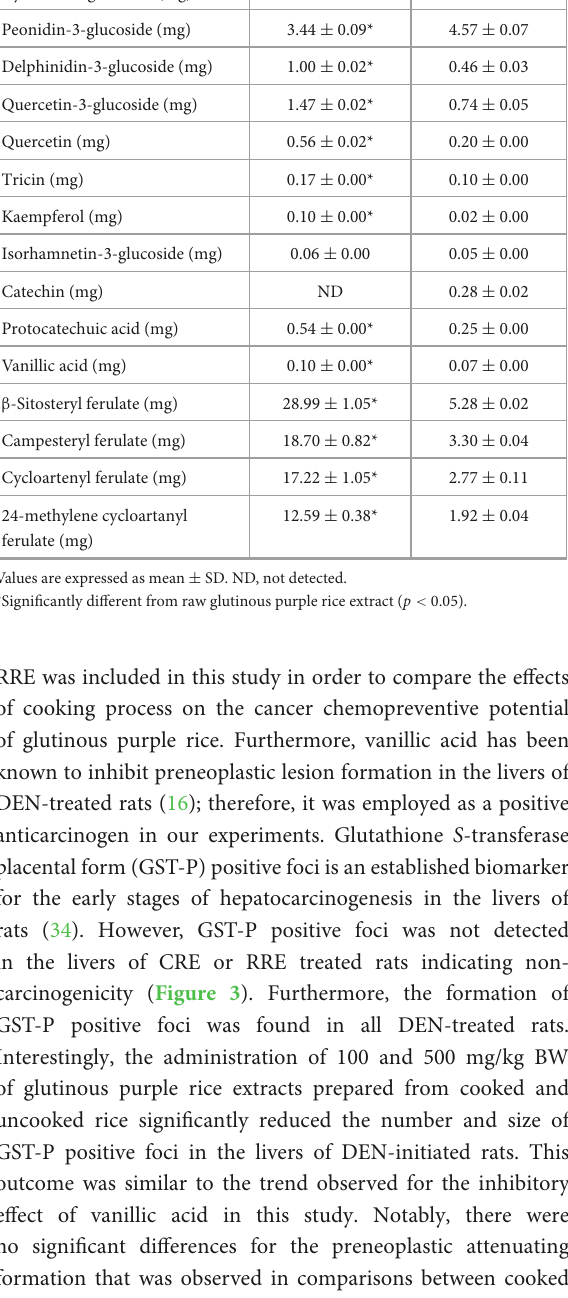
Cooked glutinous purple rice